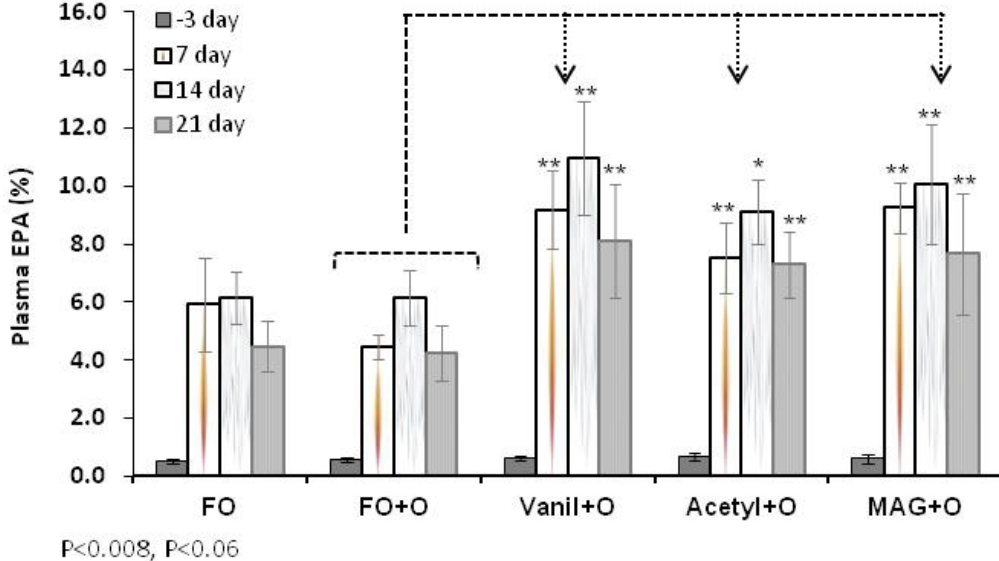
Figure 3. EPA in plasma at different time points, Median ±